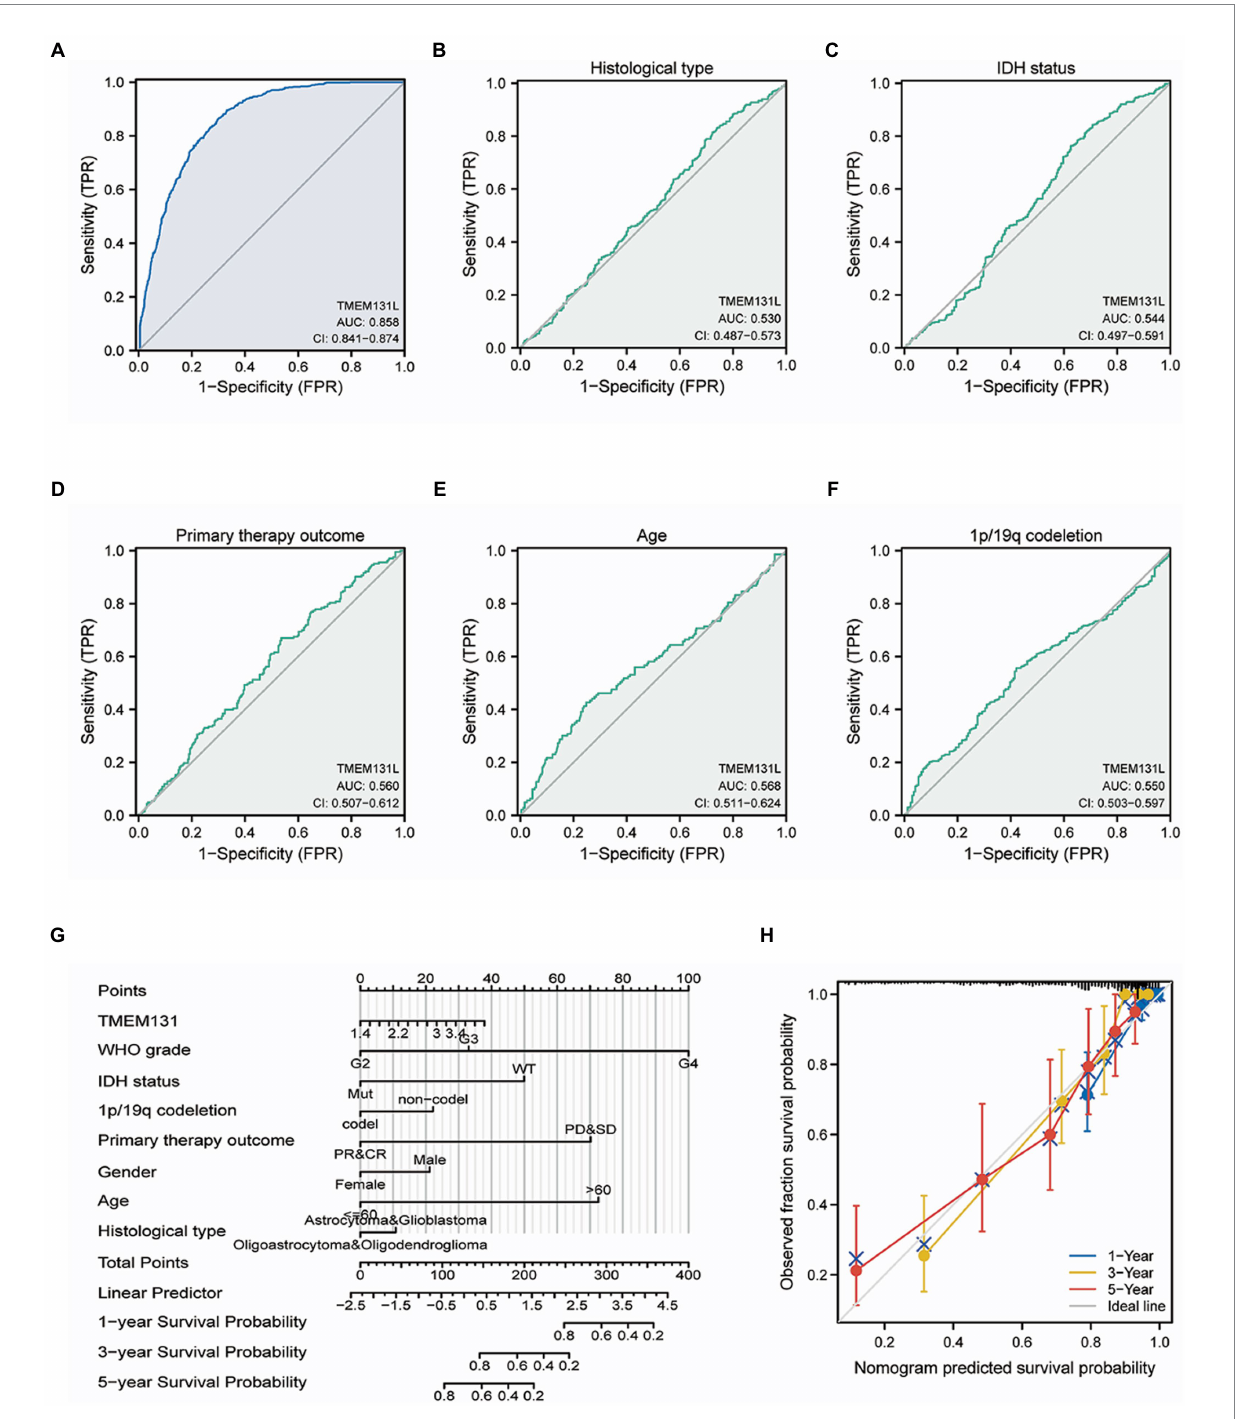
FIGURE 4 Differential efficacy of TMEM131L for the diagnosis and clinical variables of GBM and LGG. (A) Analysis of the diagnostic efficacy of TMEM131L for GBM and LGG. (B–F) Diagnostic efficacy of TMEM131L on Histological type, IDH status, Primary therapy outcom, Age, and 1p/19q codeletion; (G,H) Nomogram and calibration curve of TMEM131L and clinical